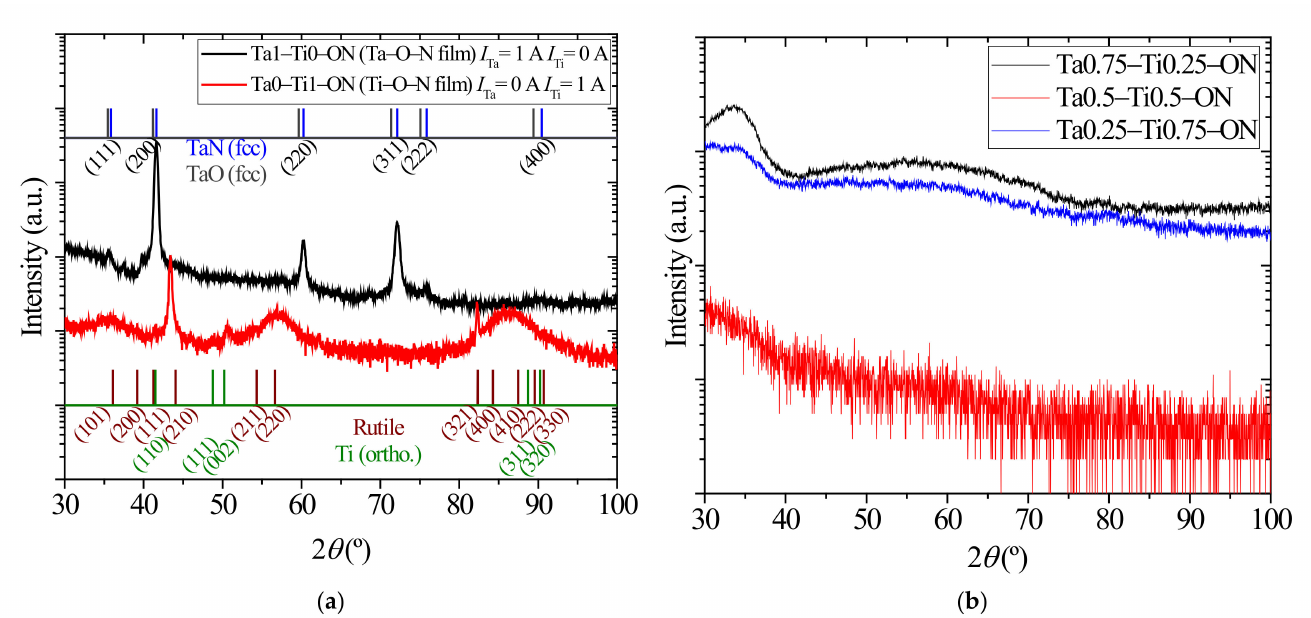
Figure 3. Grazing incidence XRD patterns of the single-sputtered coatings ( a ) and co-sputtered coatings ( b